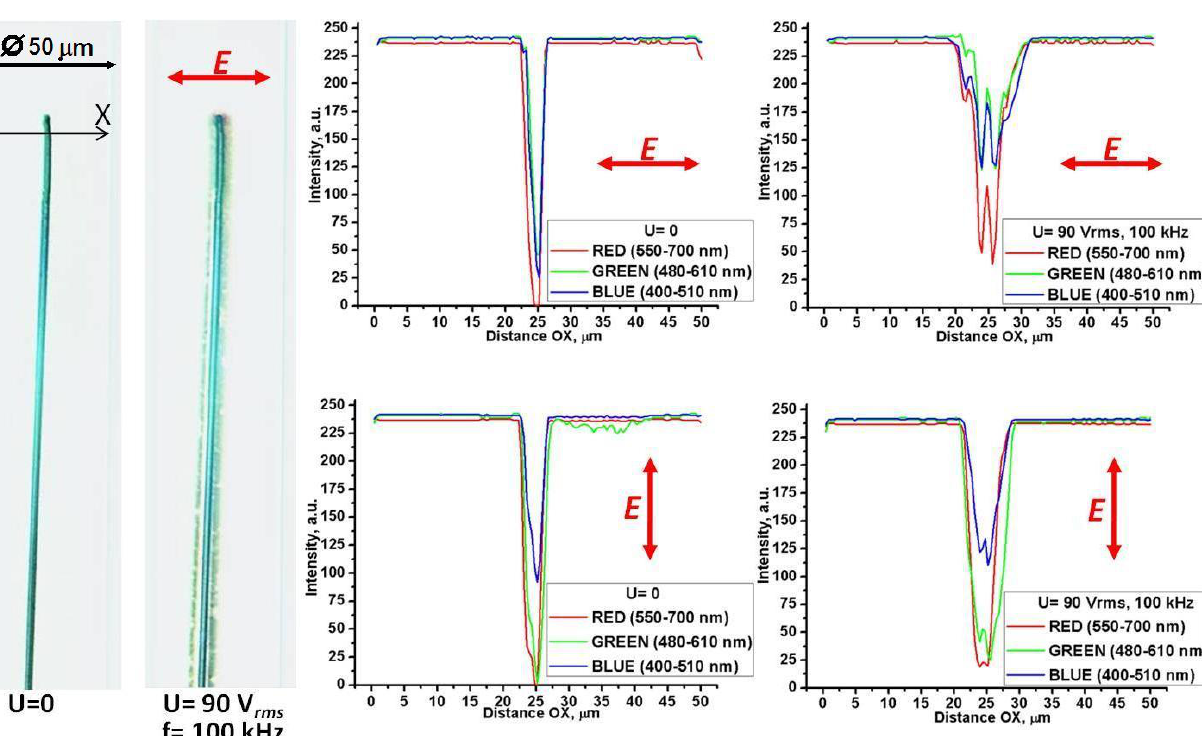
Figure 13. Variable visibility of the central electrode (2) in a cylindrical capillary (1) filled with toluene dispersion of “short/thin” Au NRs, shown by the textures at zero voltage (left texture) and at the voltage 90 V , 100 kHz (right texture). Observation under the rms microscope with light polarized normally to the capillary axis. The right part of the figure illustrates how the light transmission changes along the direction OX for light polarized normally to the capillary (top row) and parallel to it (bottom